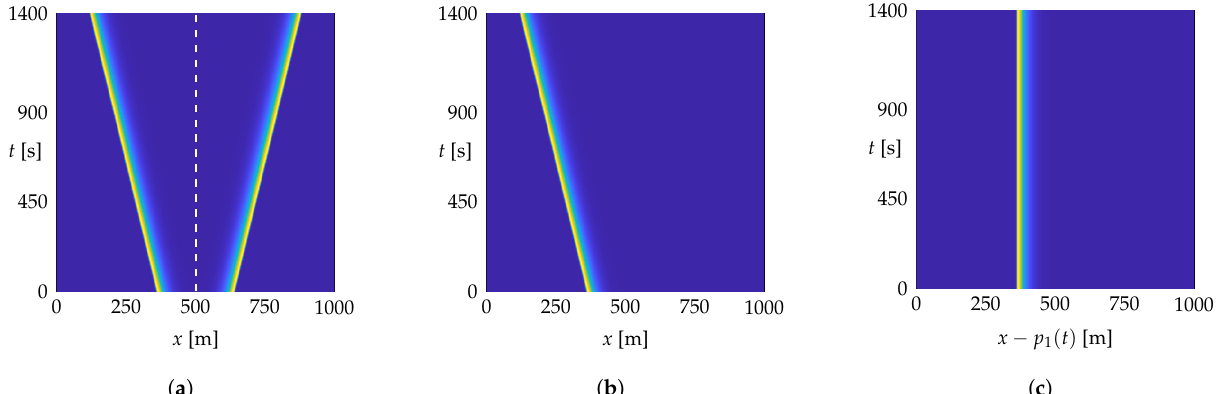
Figure 3. Illustration of the separation procedure for the snapshot data: original snapshot data ( a ), left-going combustion wave ( b ), and left-going combustion wave in the co-moving frame ( c